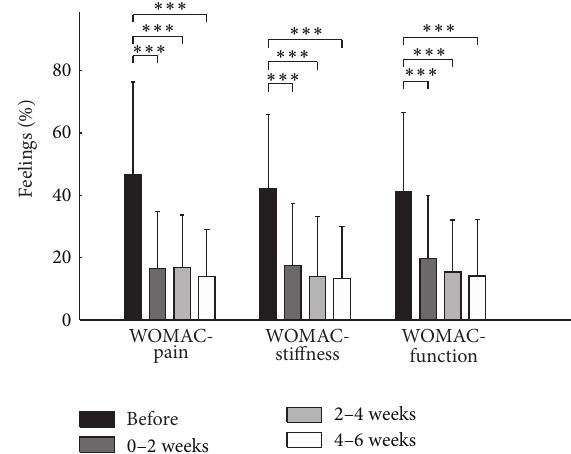
Figure 2: Answers to the questionnaires divided into different domains and collected before injection and every two weeks after injection for six weeks. ∗∗∗ 𝑃 < 0.001.